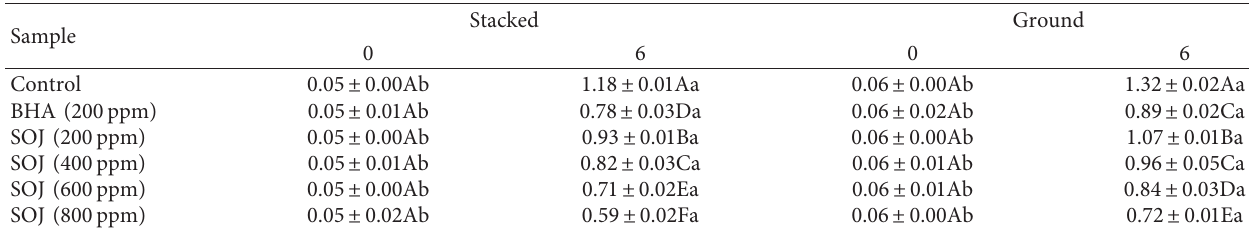
Table 6: TBA (mg MDA/kg) stacked and ground meat samples incorporated with Shahpouri Orange Juice (SOJ) and BHA during storage at 4 ° C for 6